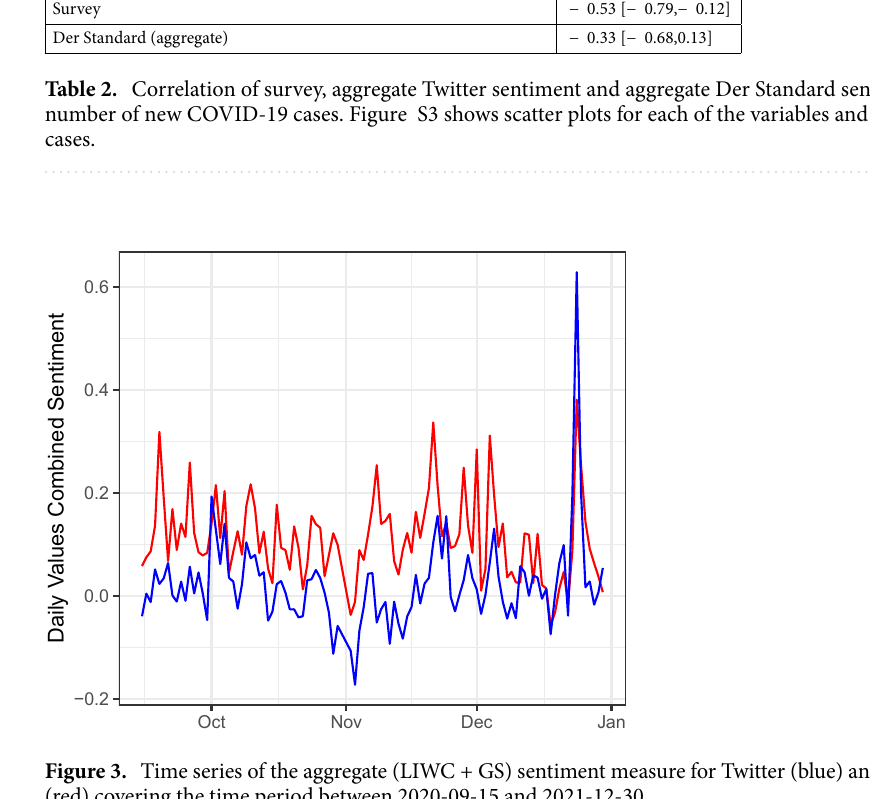
Figure 3. Time series of the aggregate (LIWC + GS) sentiment measure for Twitter (blue) and Der Standard (red) covering the time period between 2020-09-15 and